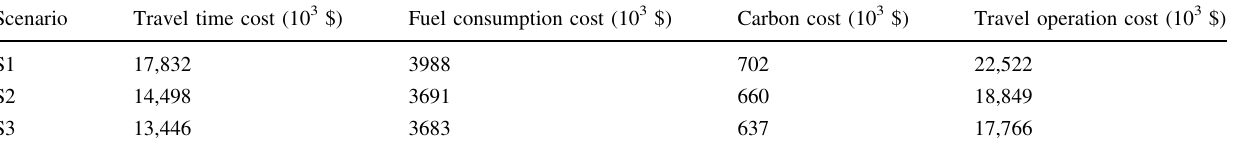
Table 4 Comparison of scenario costs Scenario